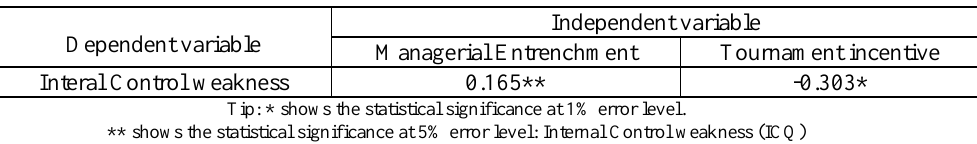
Table 5. Pearson correlation coefficient